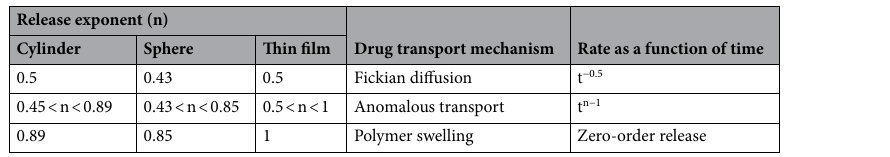
Table 2. Diffusional drug release from polymeric systems 49 .